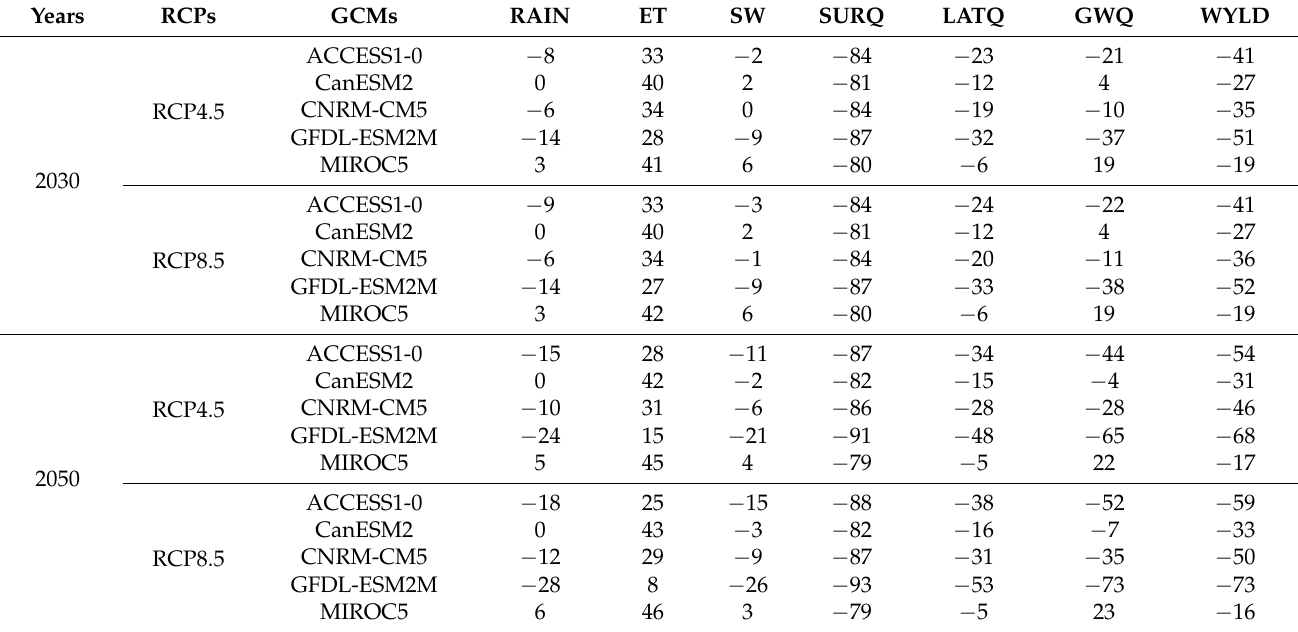
Table 5. Change in annual hydrologic components (%) as projected by the climate models and